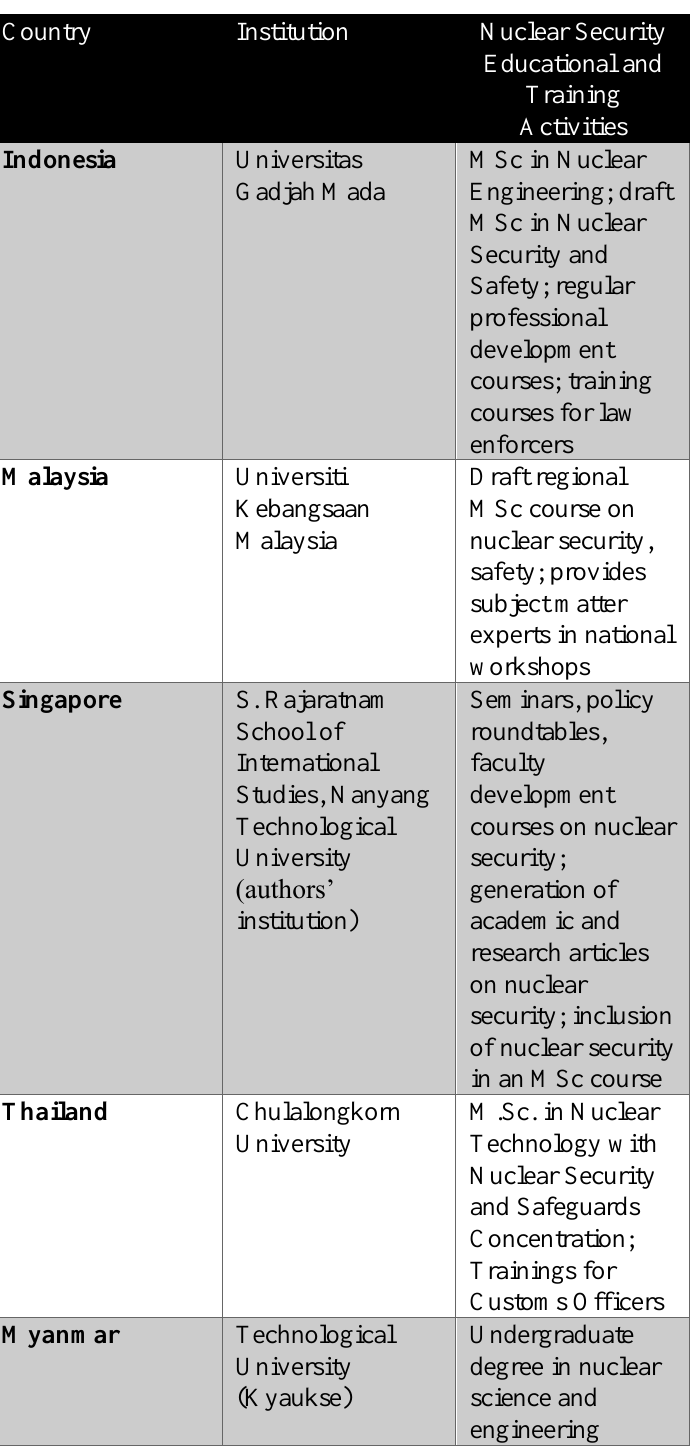
Table 1. Southeast Asia’s INSEN Members